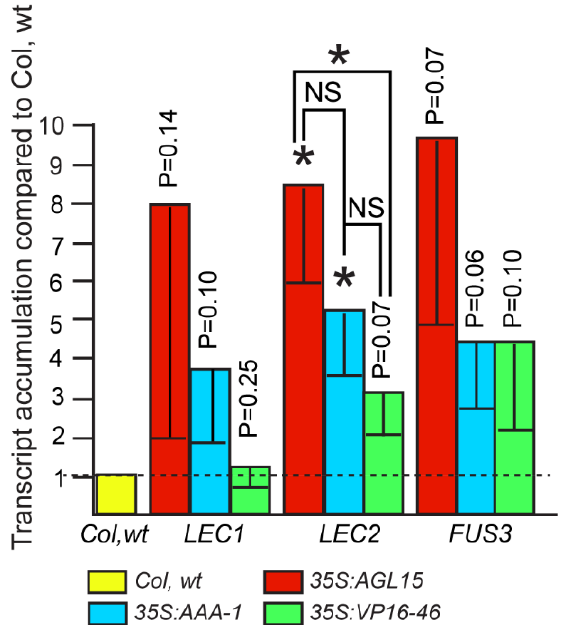
Figure 3. Transcript accumulation from genes encoding key embryo transcription factors in response to the different forms of AGL15. The results shown are the means and standard error of the mean for at least five biological replicates. * indicates significance compared to Col wt or the indicated comparison at p < 0.05 as assessed with a Student’s t -test. NS, not significant. Differences in transcript accumulation for LEC1 and FUS3 between the different transgenic backgrounds were NS for all biological replicates considered as a whole.